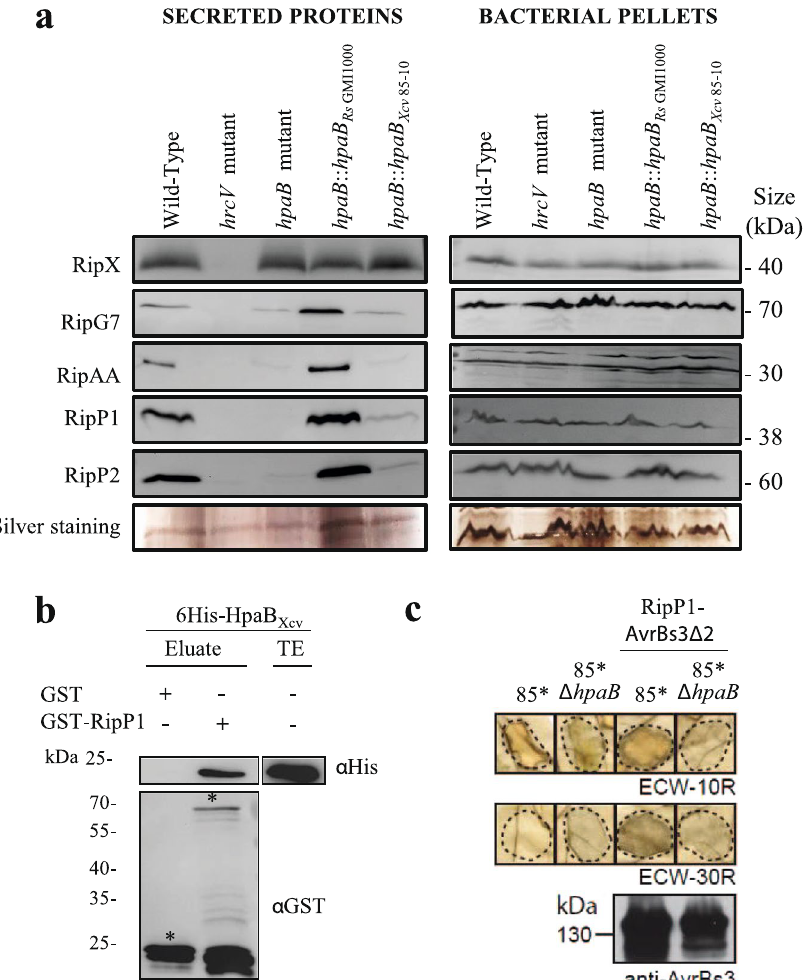
Figure 6. HpaB Xcv can functionally control RipP1 secretion/translocation in R . solanacearum and in X . campestris pv. vesicatoria and is able to bind RipP1. ( a ) Lack of secretion of RipP1 and RipP2 in R . solanacearum hpaB mutant is partially restored when complementing with the Xcv 85-10 hpaB gene. R . solanacearum secretion assays were performed in type III inducing conditions, for the GMI1000 wild-type strain, the hrcV mutant, the hpaB mutant and the hpaB mutant complemented with the hpaB gene from R . solanacearum GMI1000 or the hpaB gene from Xcv 85-10 . Total proteins from bacterial pellets and supernatants were analyzed by Western-blot using specific antibodies or total proteins were stained by silver nitrate. ( b ) HpaB Xcv binds R . solanacearum RipP1 T3E. Glutathione S-transferase (GST) and GST-RipP1 were immobilized on glutathione sepharose and incubated with an E . coli lysate containing 6His-HpaB Xcv . Total extract (TE) and eluted proteins were analyzed using antibodies directed against the 6His epitope and GST respectively. Bands corresponding to GST and GST fusion protein are marked by asterisks. ( c ) RipP1 R . solanacearum T3E is heterogously translocated by Xcv , in an HpaB dependent manner. For this experiment, the wild-type strain Xcv 85-10 (85 * ) and the hpaB Xcv mutant (85 * Δ hpaB) both carry hrpG * , a mutated version of the key regulatory gene hrpG in the bacterial chromosome (Büttner et al ., 2004). Xcv 85 * and 85 * Δ hpaB strains, and derivatives containing RipP1-AvrBs3 Δ 2 construct, were infiltrated into leaves of ECW-10R (carrying Bs1 resistance gene) and ECW-30R (carrying Bs3 resistance gene) pepper plants. Bacteria were infiltrated at OD 600 of 0.2 (corresponds to 2 × 10 8 cfu/ml). Leaves were bleached 2 dpi for better visualization of the HR. Dashed lines indicate the infiltrated areas. For protein analysis, bacteria were grown ON in NYG medium. Equal amounts of cell extracts (adjusted according to OD) were analyzed by SDS-PAGE and immunoblotting, using an AvrBs3-specific antibody. For ( a ), ( b ) and ( c ), two biological replicates were done with similar